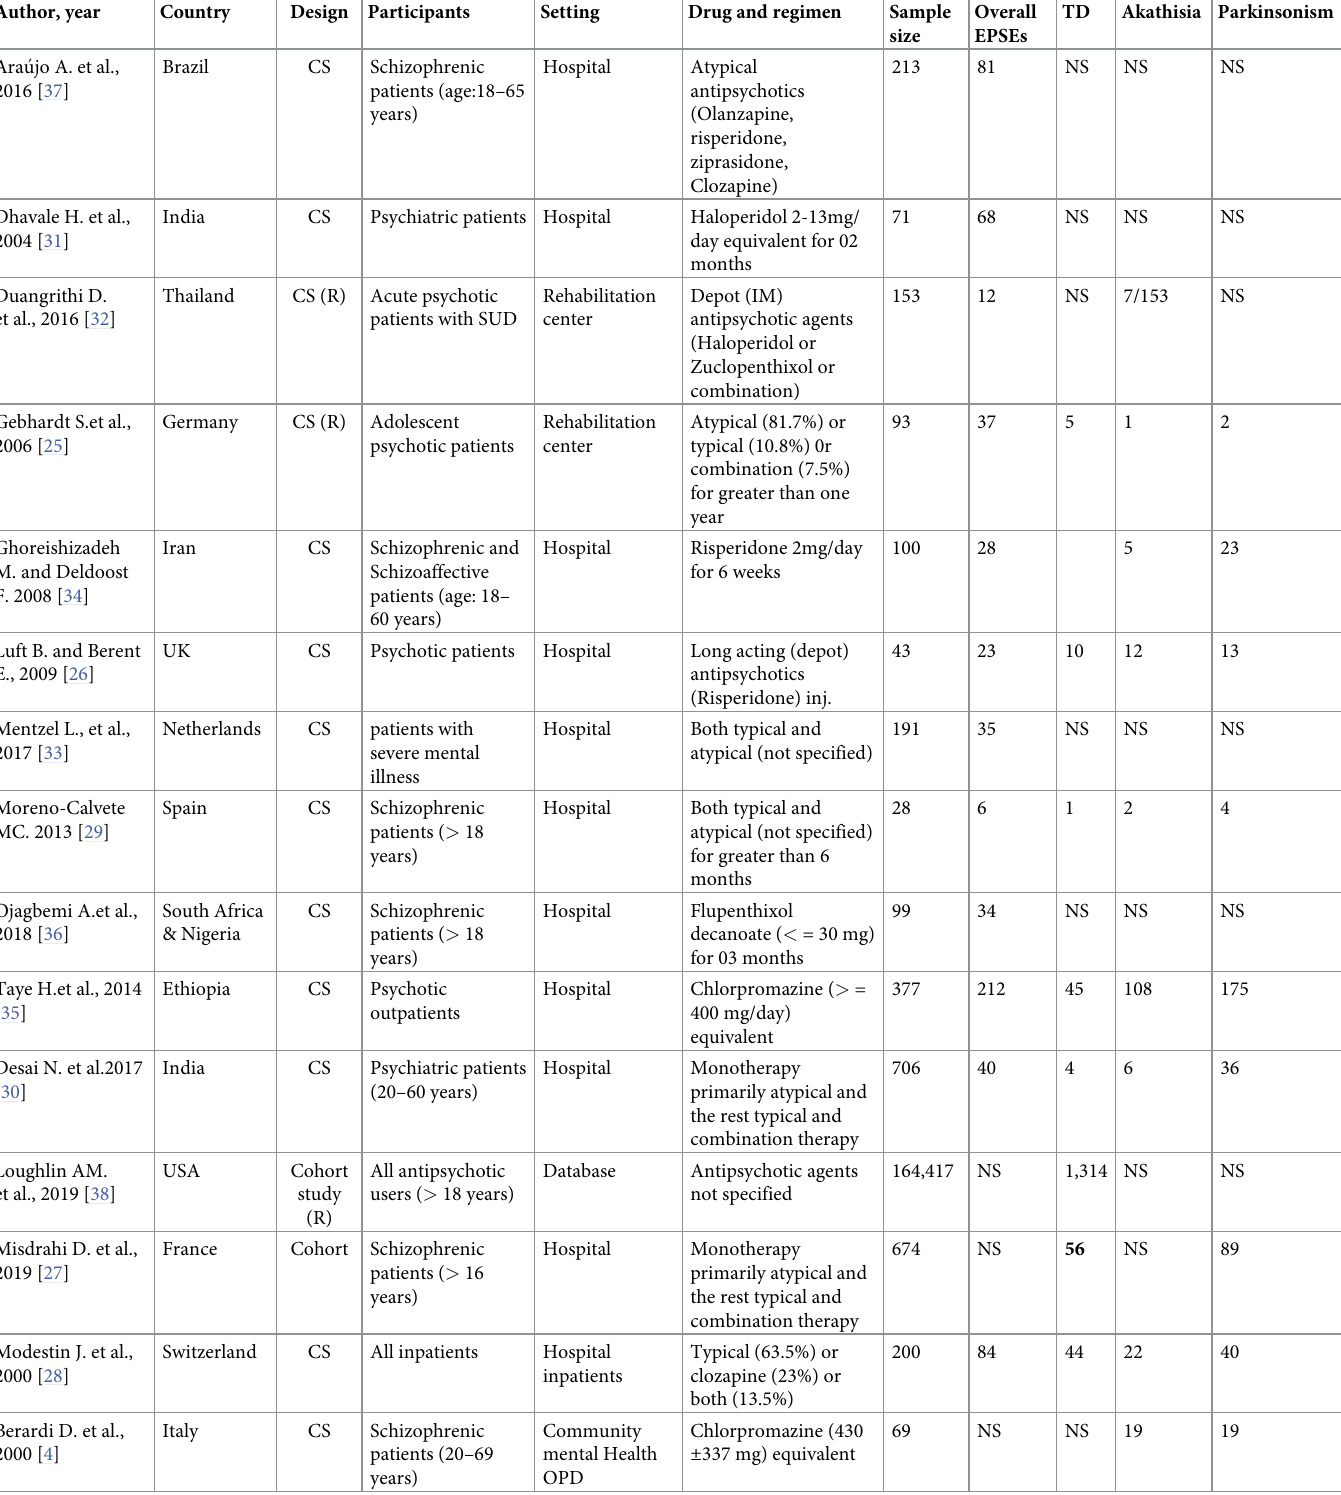
Table 1. Summary of studies included in the systematic review and